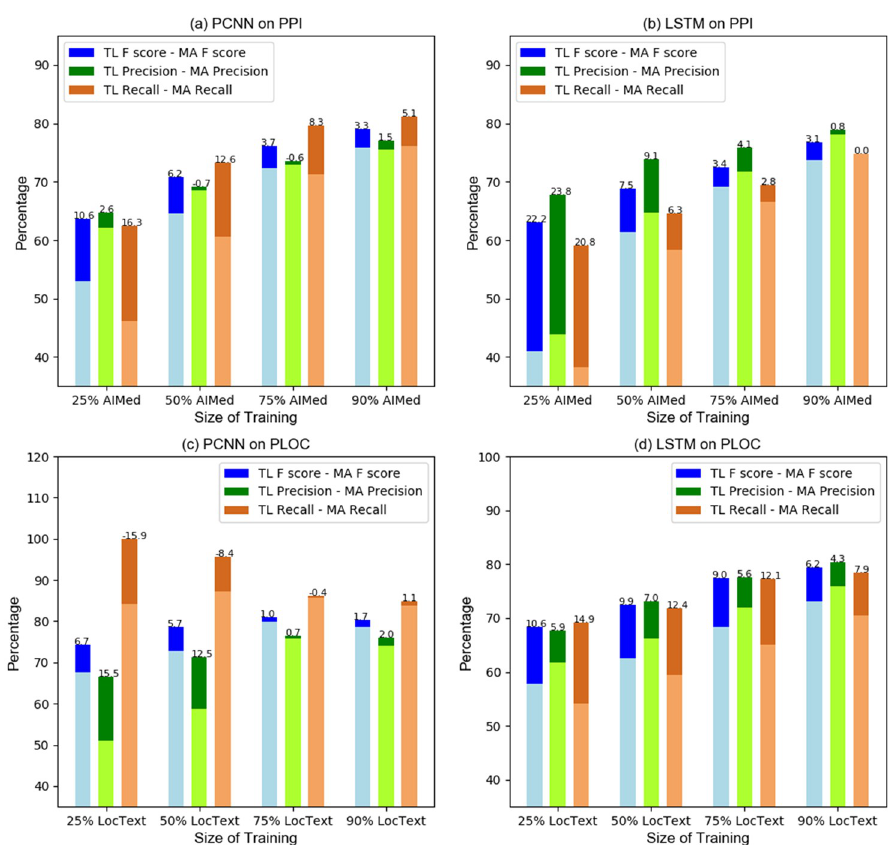
Fig 6. Size effect of human-labeled dataset. The number on each bar stands for the difference between None Transfer Learning and Transfer Learning model. Positive number means Transfer Learning improves the metric, while negative number means Transfer Learning deteriorates the